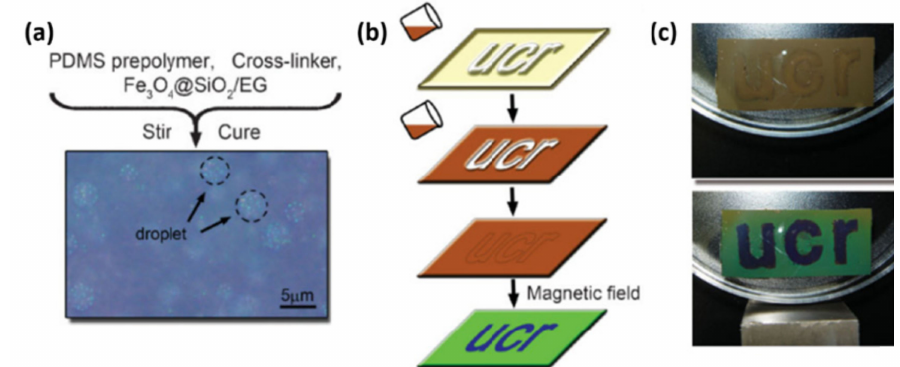
Figure 11. Invisible colloidal PC pattern shown by the magnetic field fabricated by self-assembly of super-paramagnetic nanoparticles with di ff erent sizes. ( a ) The optical microscope image shows that EG solvent containing Fe 3 O 4 @SiO 2 superparamagnetic particles was dispersed as circular droplets into the PDMS matrix. ( b ) Schematic diagram of a two-step procedure for fabricating a patterned print shown by a magnetic field. ( c ) The blue / green color contrast of the prints can appear with the application of an applied magnetic field. Reused with permission from Reference [67], Copyright 2008,